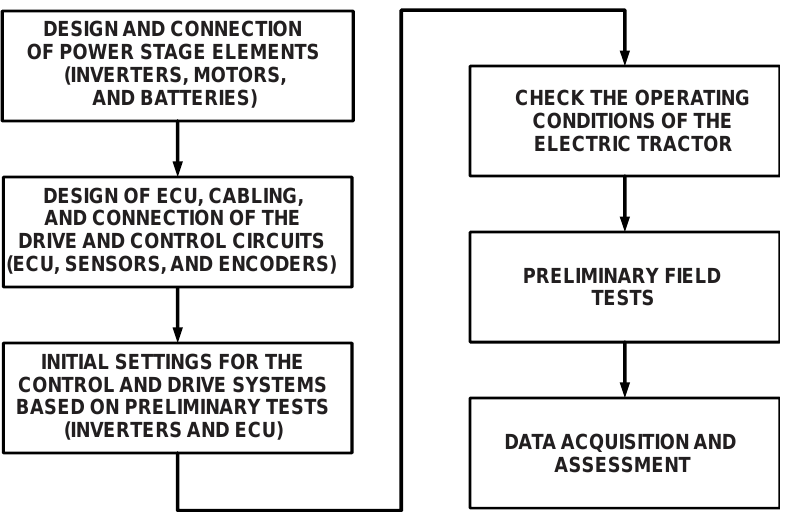
Figure 13. Flowchart representing the design procedure of the electric tractor powertrain and slip control system.